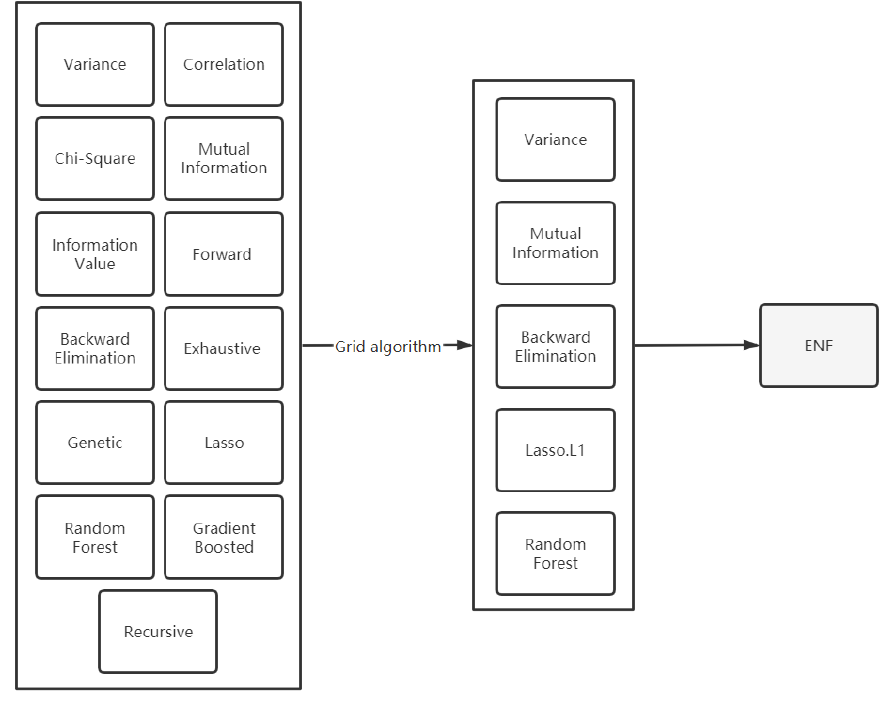
Figure 2. Basic principle of feature selection algorithm.